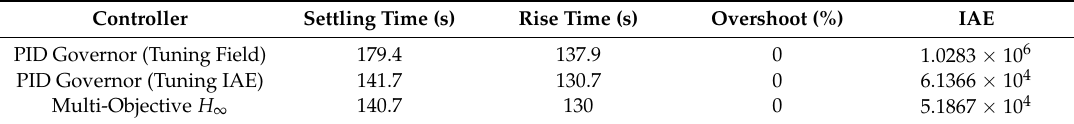
Table 4. Comparison between the set-point performance indexes of the different controllers.